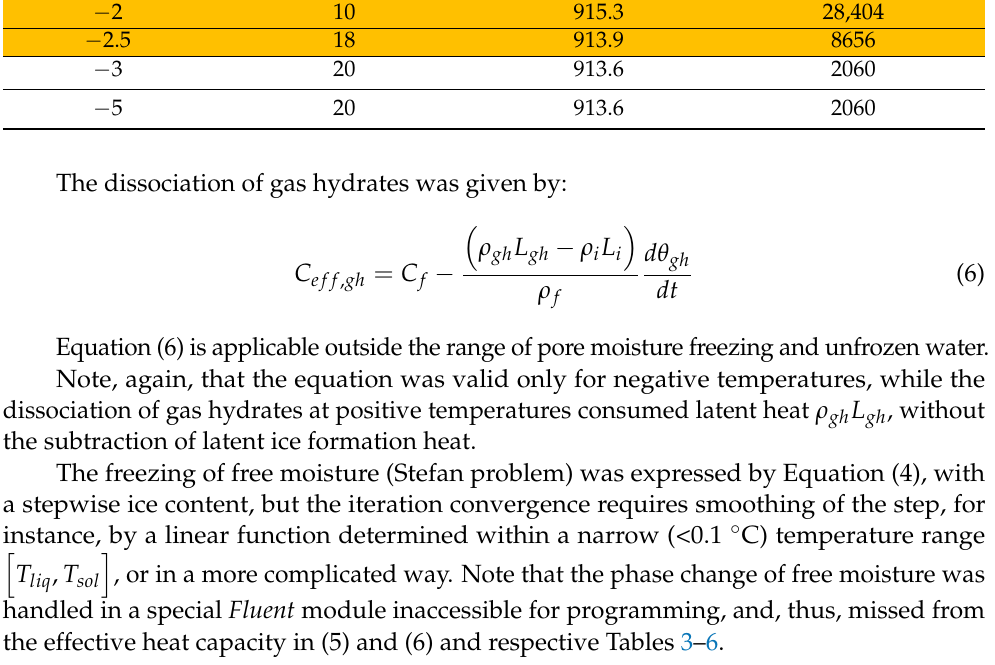
Table 5. Thermal properties of lean clay containing 20% of pore gas hydrates and 30% air (depth interval 60–120 m), with regard to the phase state of pore moisture and temperature. Temperature, ◦ C Hydrate Saturation, %